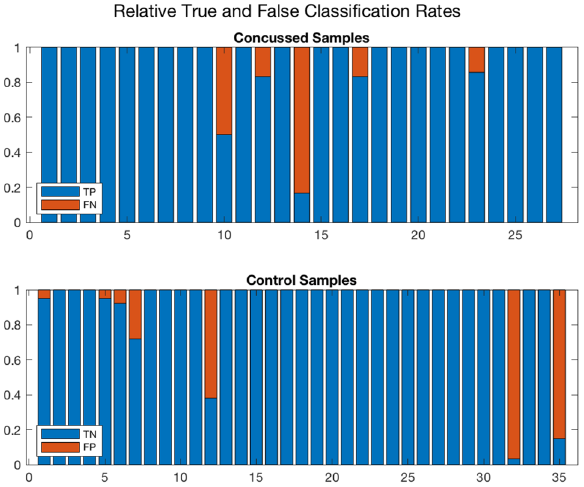
Figure 6. A different representation of the Monte Carlo cross validation test results for the 27 concussed and 35 control samples. The blue and red regions in each column illustrate the relative fractions of times